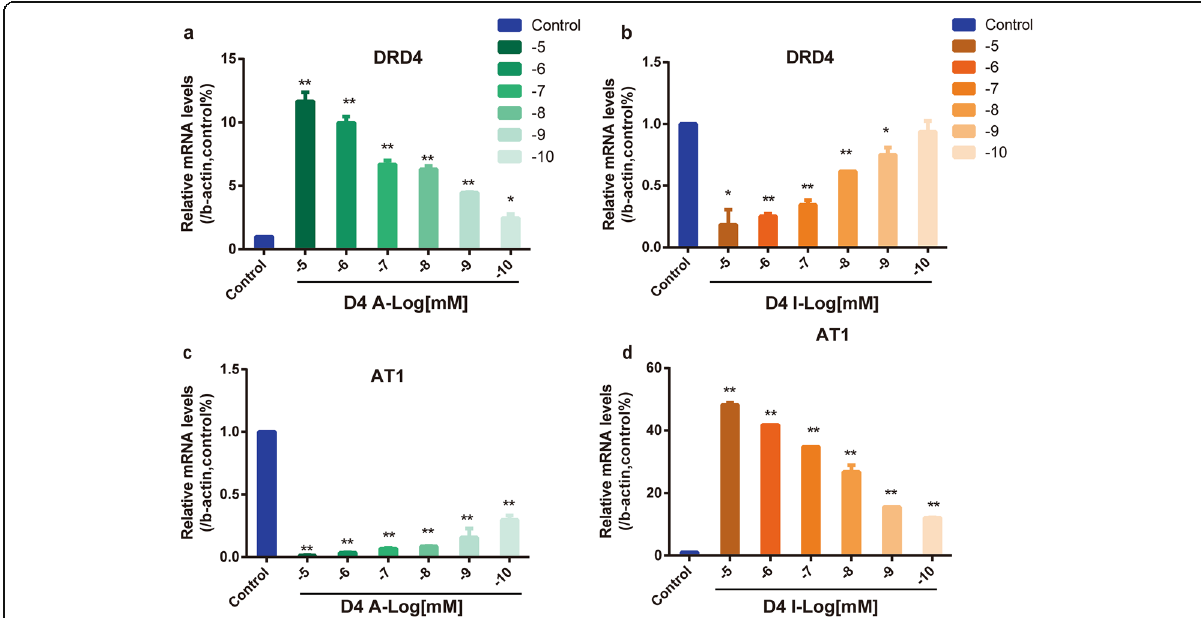
Fig. 8 Effect of dopamine receptor D4 (DRD4) on the relative abundance of angiotensin II type 1 receptor (AT1) mRNA in primary VSMCs of broilers. VMSCs were incubated with different doses of D4A or D4I for 24 h. a , b Dose-dependent effect of D4A (HY-101384A) or D4I (HY-B0965) ( n = 6, ** P < 0.01, * P < 0.05 vs. control). c , d Dose-dependent effect of D4A or D4I ( n = 6, ** P < 0.01 vs.